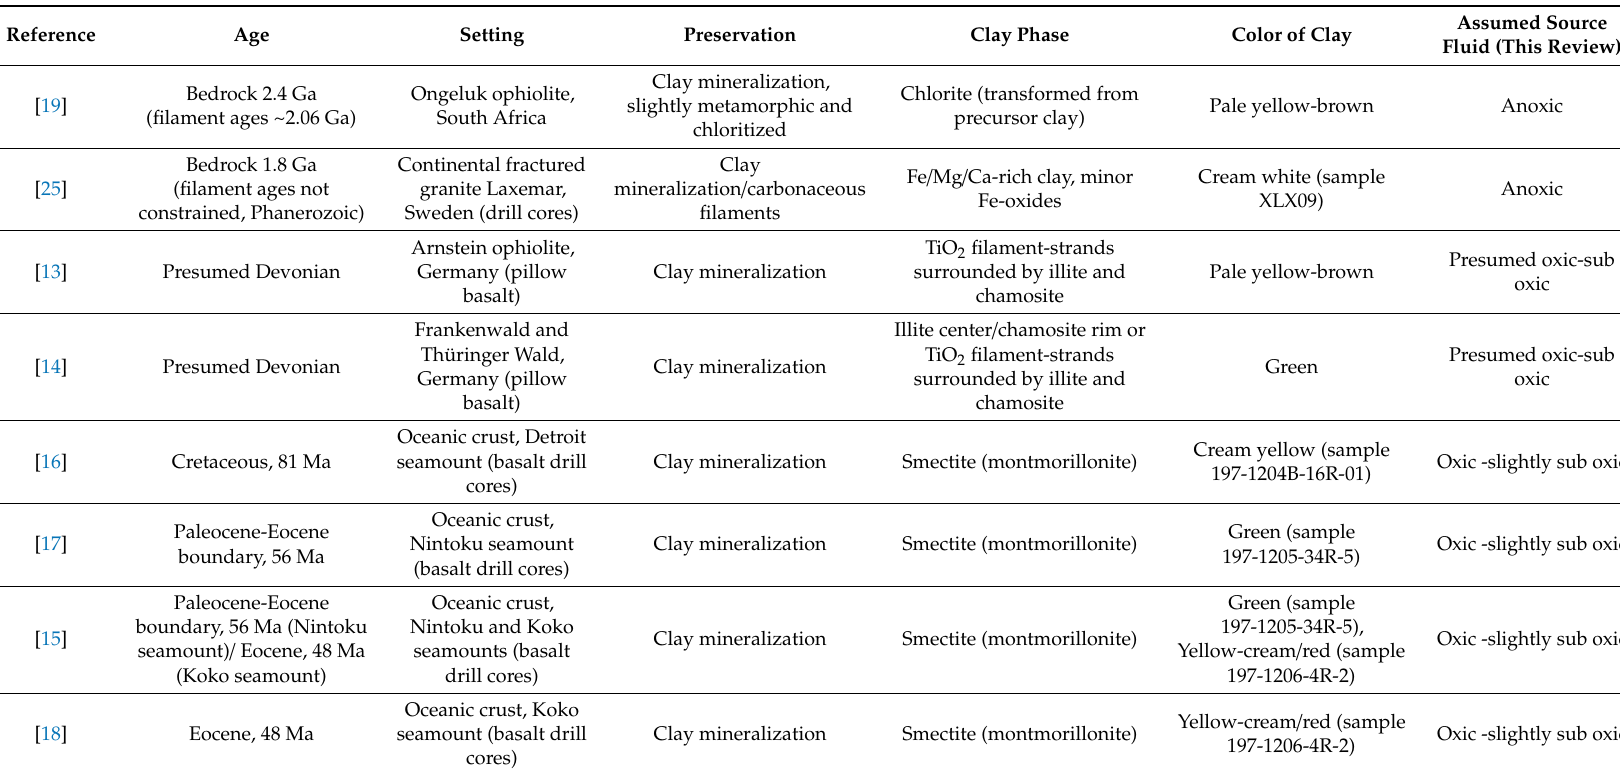
Table 1. Summary of studies focusing on subsurface clay authigenesis associated with (mainly) fungal biofilms. Publications are arranged according to age from the